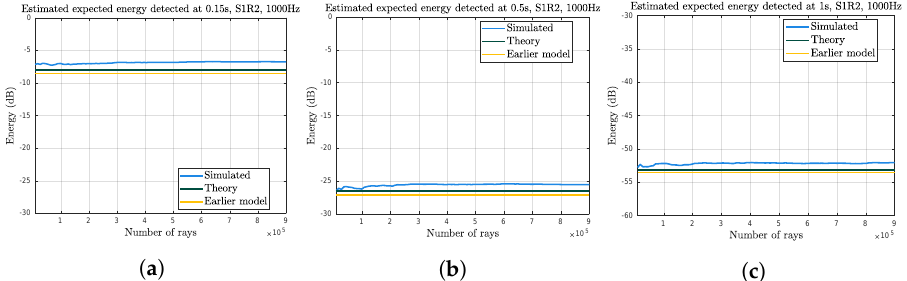
Figure 5. Graphs illustrating how the expected value of the impulse response at 0.15 s ( a ), 0.5 s ( b ) and 1 s ( c ), estimated theoretically and from simulation data, changes as the number of rays change. The theoretical estimates are both constant, and this behavior is generally repeated by the simulation data.